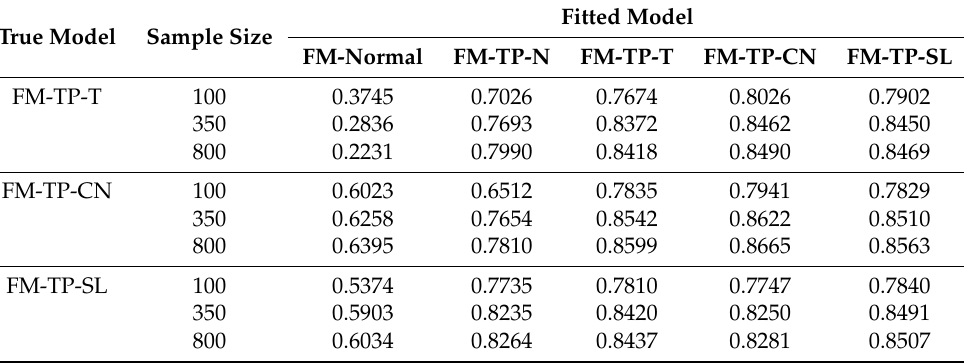
Table 1. Mean of true allocations rates for fitted finite mixture two-piece distributions based on the scale mixtures of normal (FM-TP-SMN)